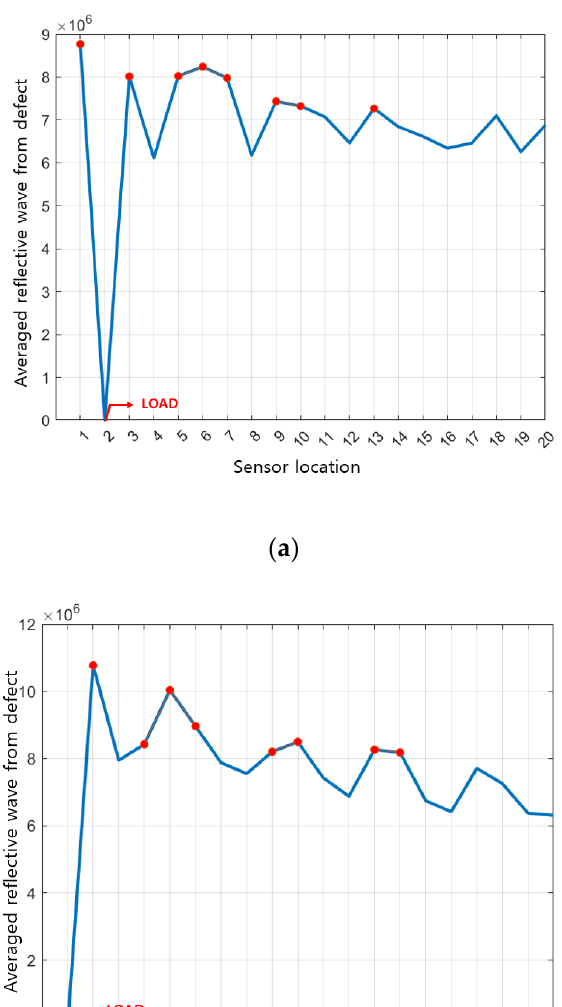
Figure 13. ( a ) Optimal transducer array configuration; ( b ) detailed dimensions of transducer array on aluminum panel.